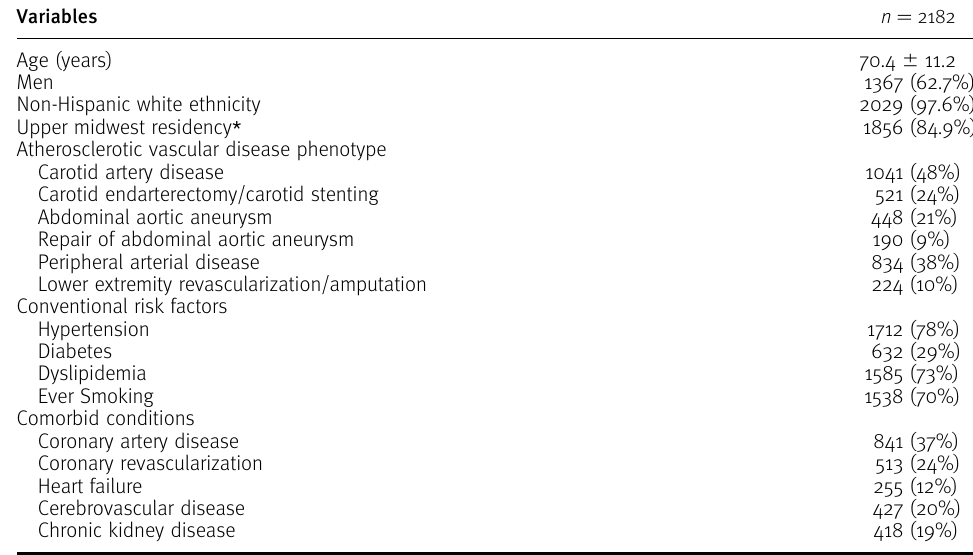
Table 3. Demographics and clinical